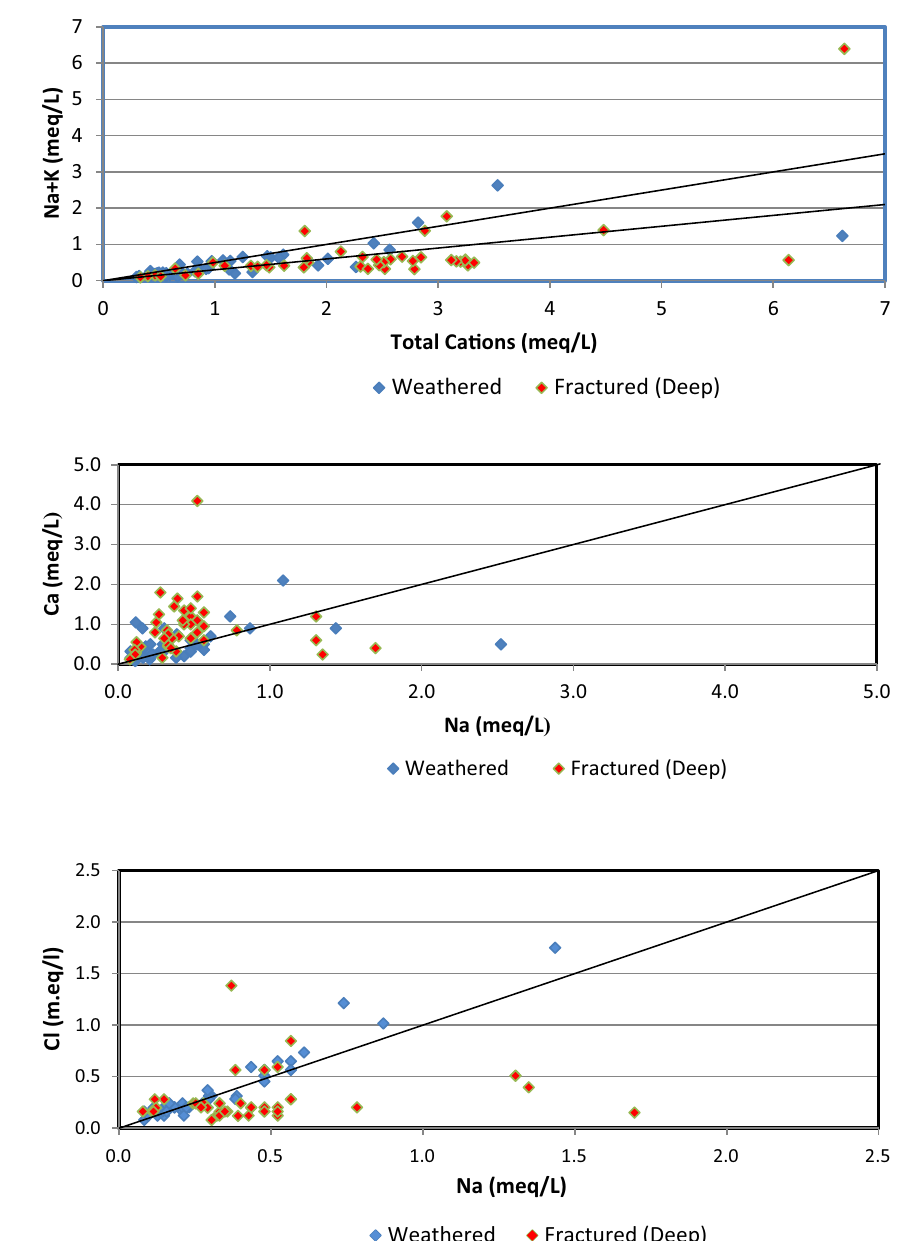
Fig. 8 Plots of Na + K versus